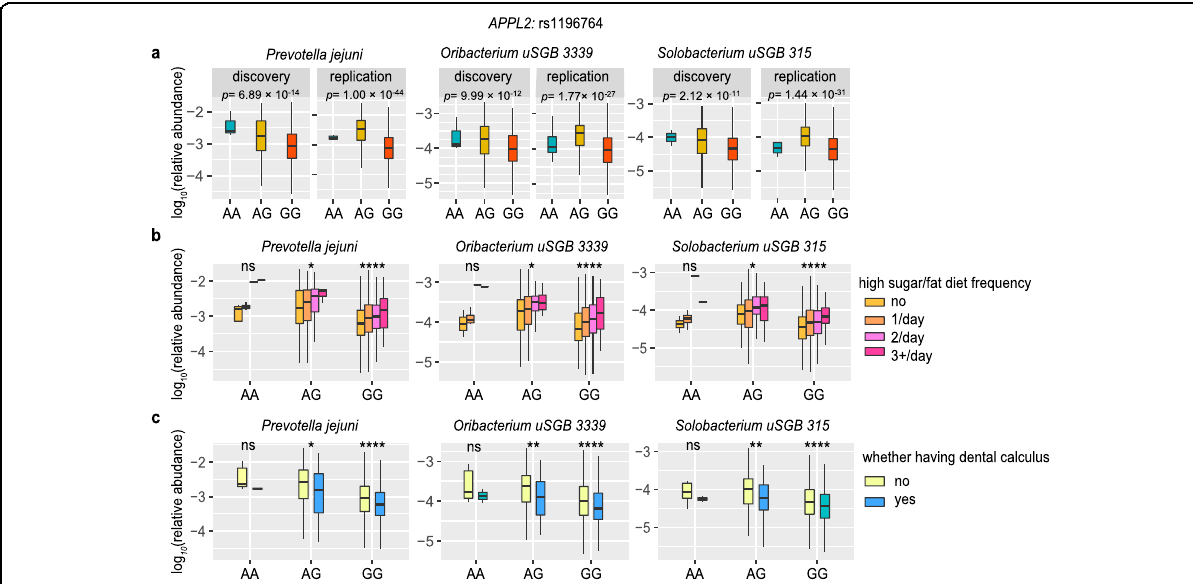
Fig. 2 The links among human APPL2 locus (rs1196764), three tongue dorsum bacteria, and diet as well as the status of dental calculus. a The three panels presented the associations of APPL2 variation with the three most signi fi cantly associated taxa: Prevotella jejuni , Oribacterium uSGB 3339 and Solobacterium uSGB 315 , which reached study-wide signi fi cance in both the discovery ( n = 2017) and replication ( n = 1333) cohorts. b Relative abundance of the three taxa across strati fi ed groups of individuals according to APPL2 : rs1196764 variation and self-reported high sugar/fat dietary frequency (colored by no intake, 1/day; 2/day; 3 + /day, respectively). c Relative abundance of the three taxa across strati fi ed groups of individuals according to APPL2 : rs1196764 variation and whether having dental calculus (yellow: no and blue: yes). All statistical comparisons in b and c denote the p values of the Wilcoxon rank test on the total 3350 individuals with log-transformed relative abundances. The signi fi cant code of p values thresholds are shown: ns, p > 0.05; * p ≤ 0.05; ** p ≤ 0.01; ** *p ≤ 0.001; * * ** p ≤